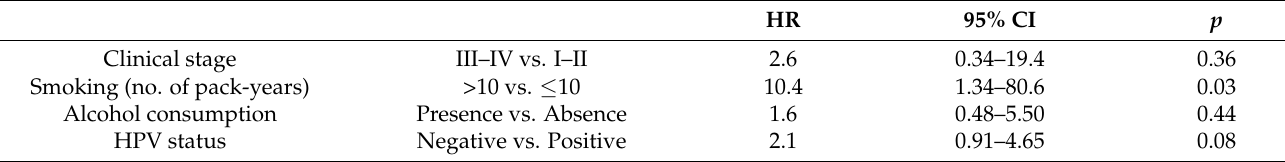
Table 5. The multivariate analysis of factors associated with OS. HR 95% CI